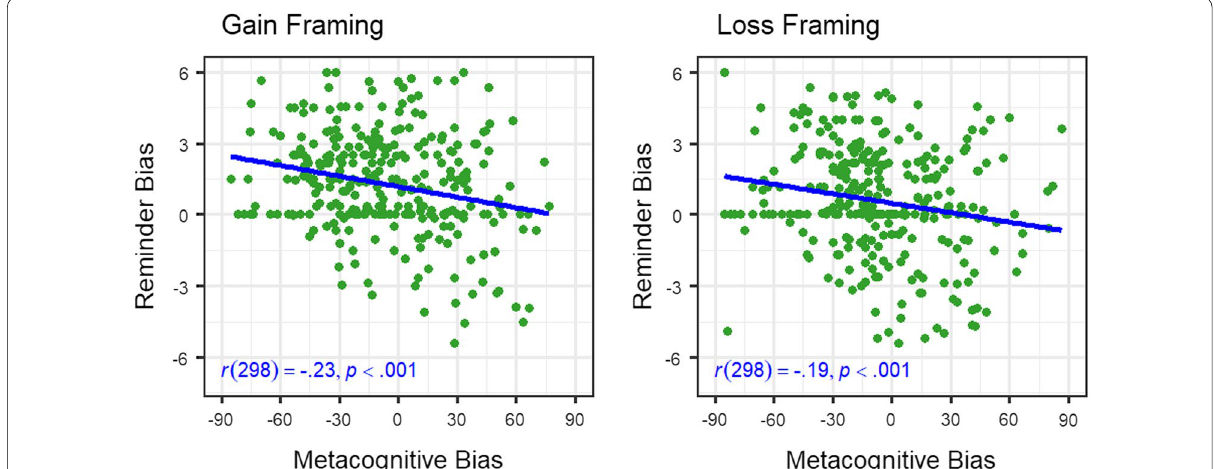
Fig. 6 Relationship between Metacognitive Confidence and Offloading Behavior. Note Correlation between individuals’ metacognitive bias and reminder bias scores, separately for both framing conditions. Negative metacognitive bias scores illustrate underconfidence in memory ability and positive reminder bias scores represent overuse of